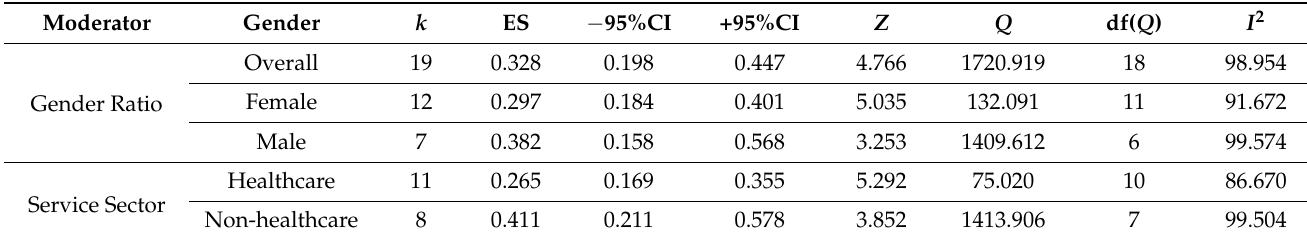
Table 2. Meta-analysis on the relationship between transformational leadership behavior and em- ployees’ psychological well-being for different genders and service